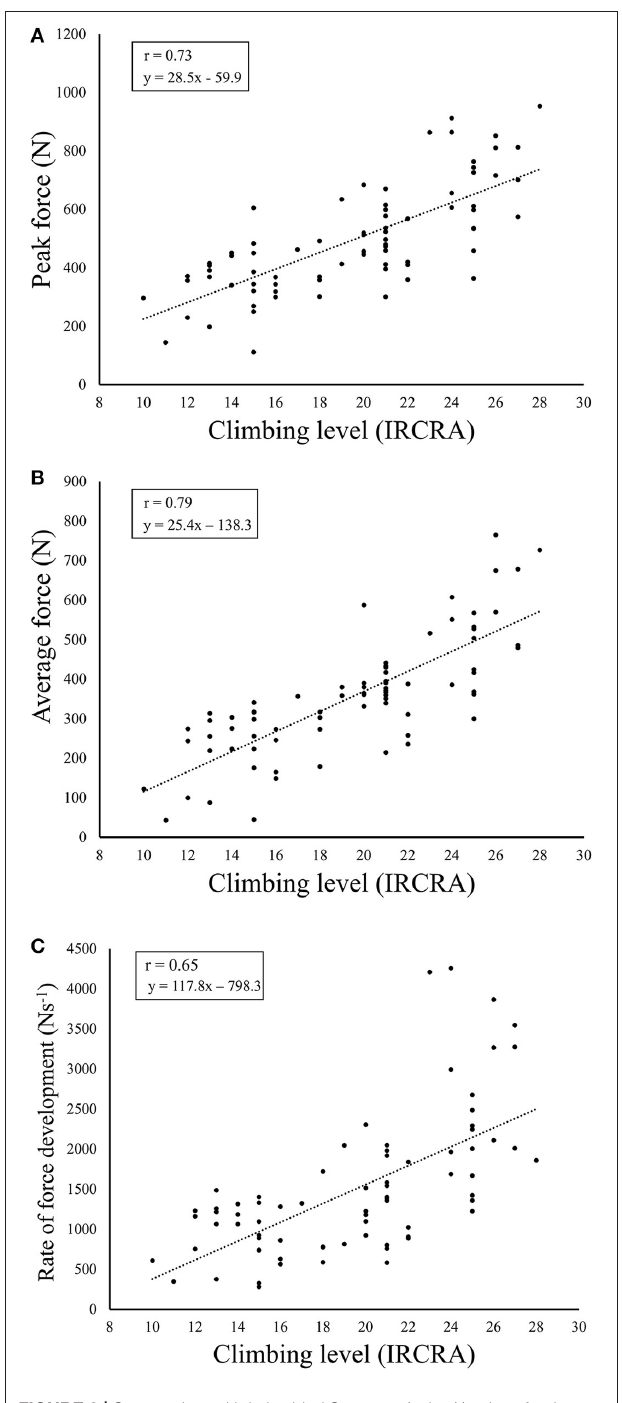
FIGURE 2 | Scatter plots with imbedded Spearman’s rho ( r ) values for the correlation between the International rock climbing research association (IRCRA) climbing performance level and (A) peak- and, (B) average force output in Newtons (N), and (C) rate of force development.